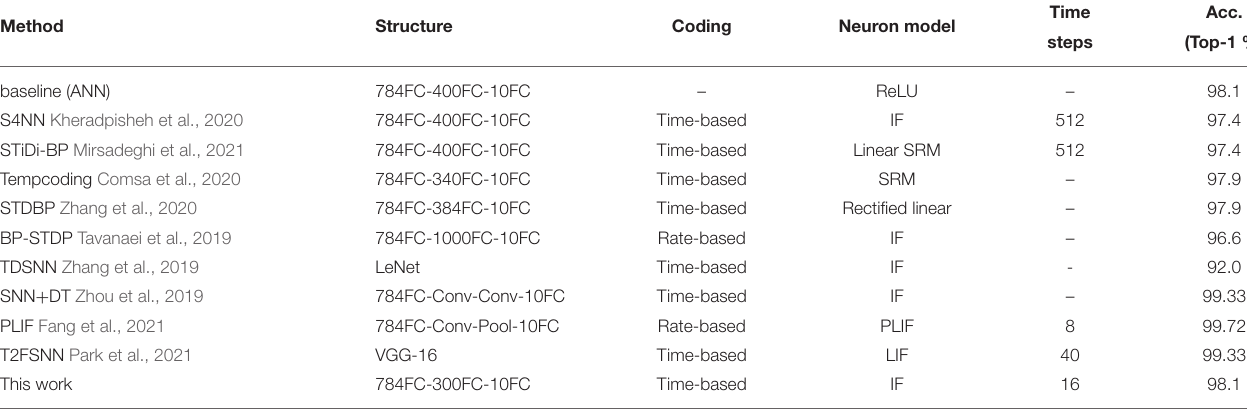
TABLE 2 | Comparsion of our work and other SNN models with direct training on the MNIST dataset.